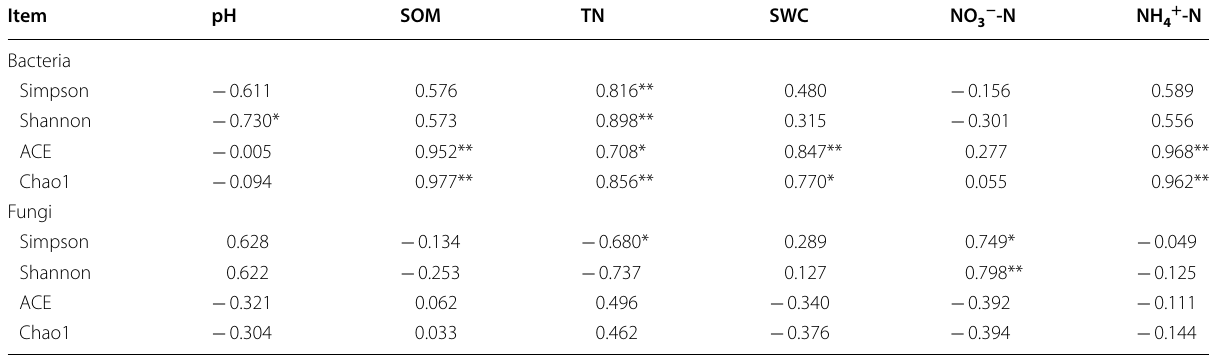
Table 2 Pearson correlation of soil chemical properties and α-diversity indexes